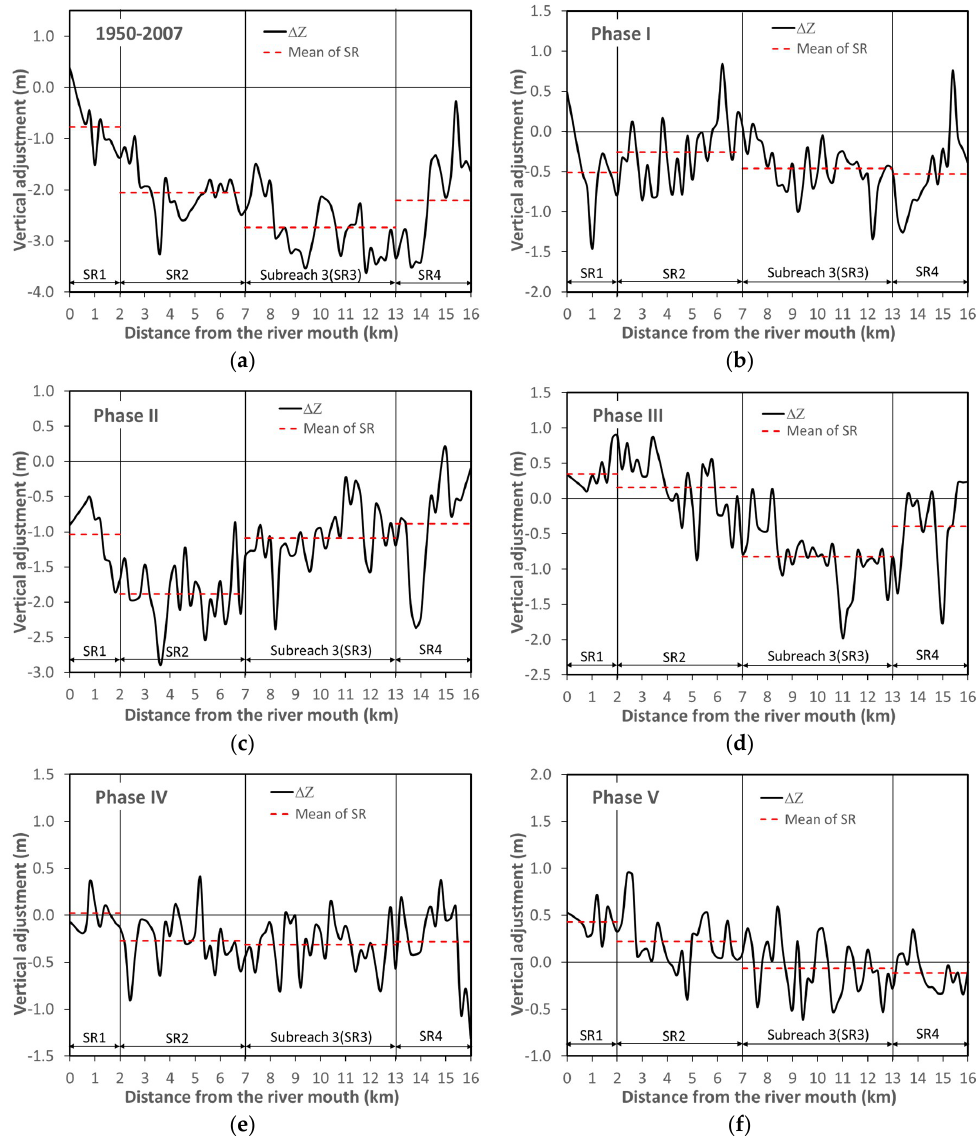
Figure 3. Vertical adjustment of riverbed elevation: ( a ) vertical adjustment in the period from 1950–2007, ( b ) vertical adjustment in phase I, ( c ) vertical adjustment in phase II, ( d ) vertical adjustment in phase III, ( e ) vertical adjustment in phase IV, and ( f ) vertical adjustment in phase V.